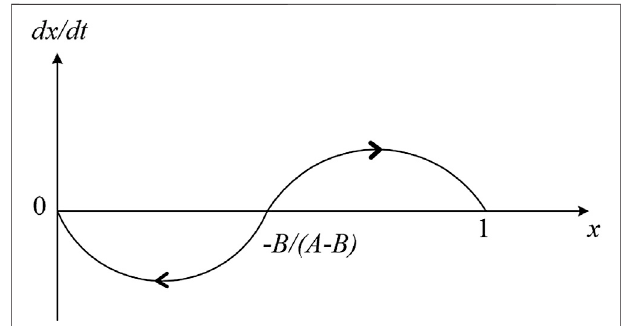
FIGURE 2 | Phase diagram of the evolutionary game.